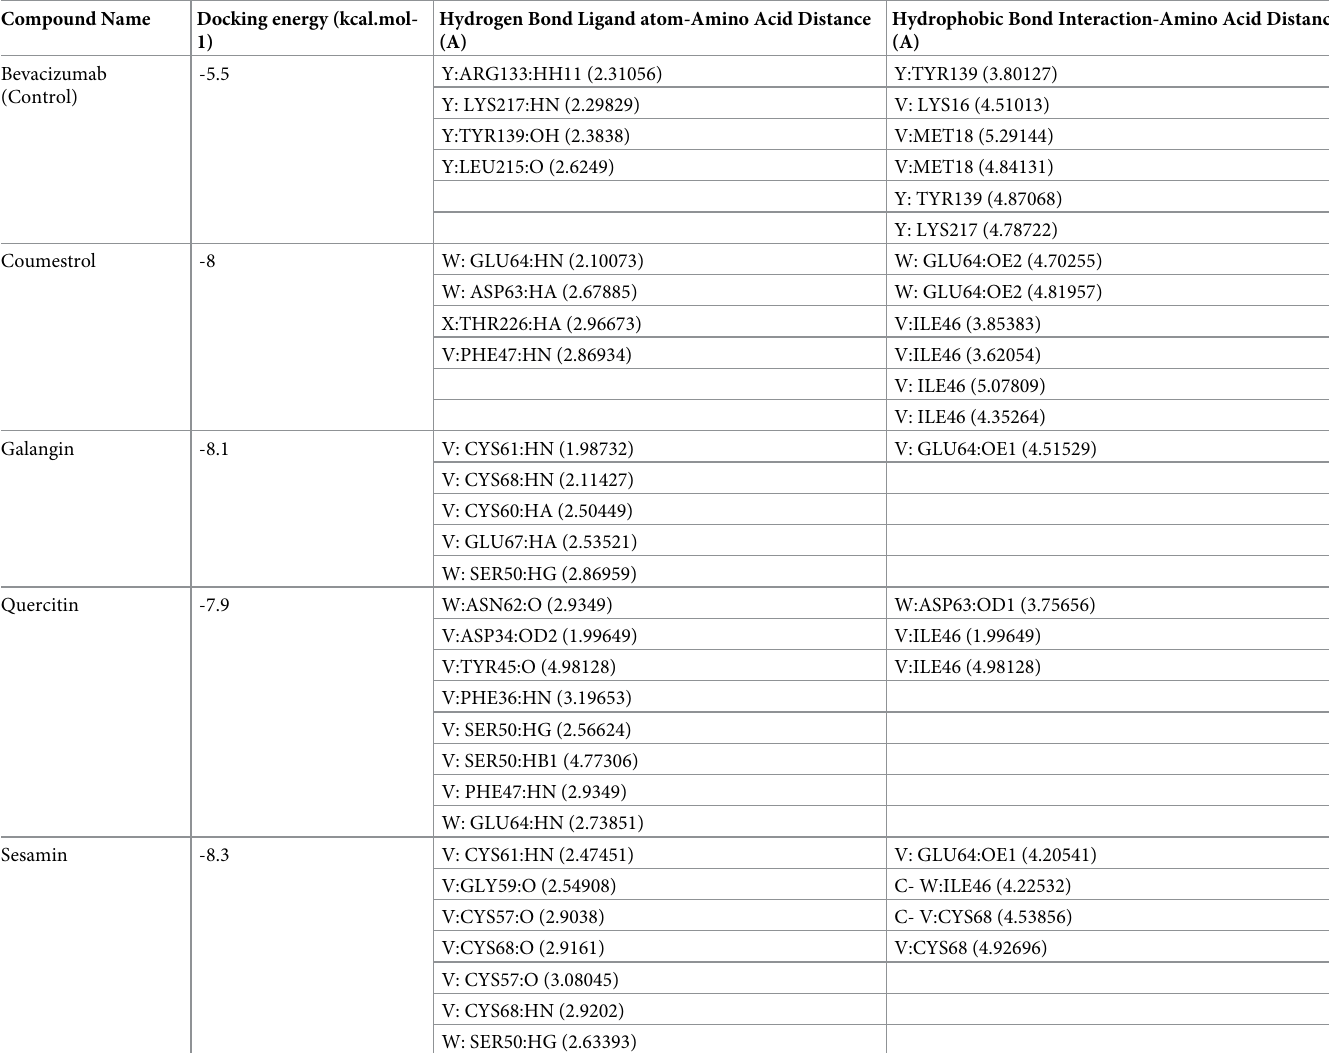
Table 6. Docking simulation results of 4 compounds with docking score energy and interaction with amino acids against VEGFA protein. Compound Name Docking energy (kcal.mol-